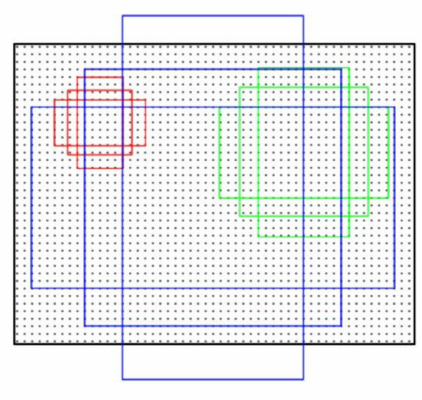
Figure 3. Multi-scale